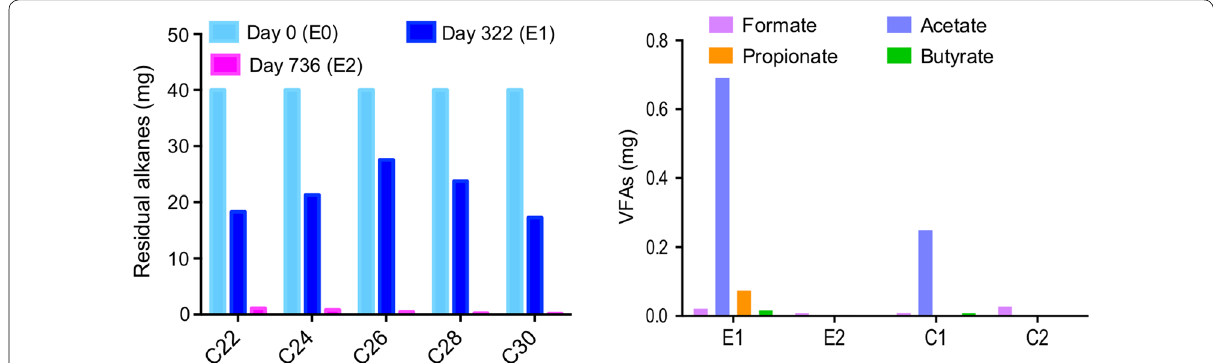
Fig. 2 Residual alkanes and volatie fatty acids (VFAs) in enrichment cultures after anaerobic